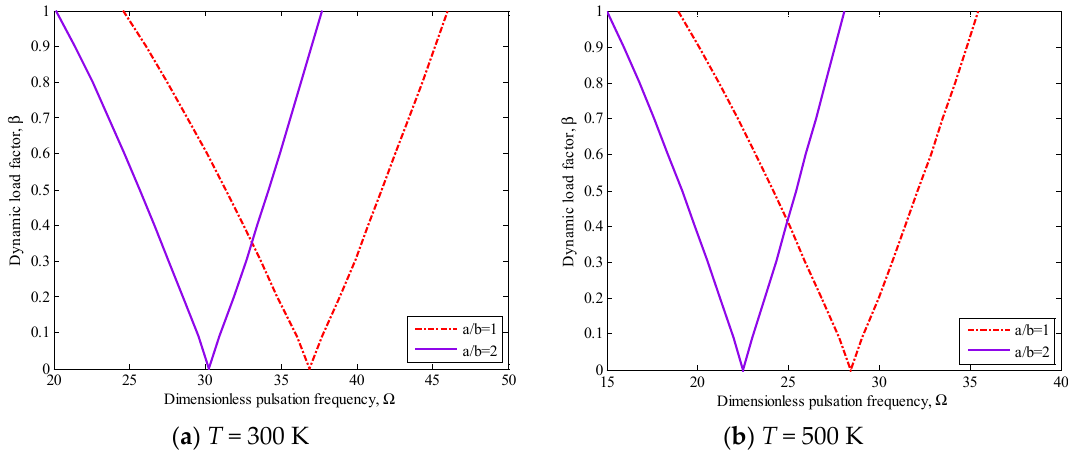
Figure 5. Aspect ratio effect on the DIR of the SLGS embedded on an elastomeric foundation.